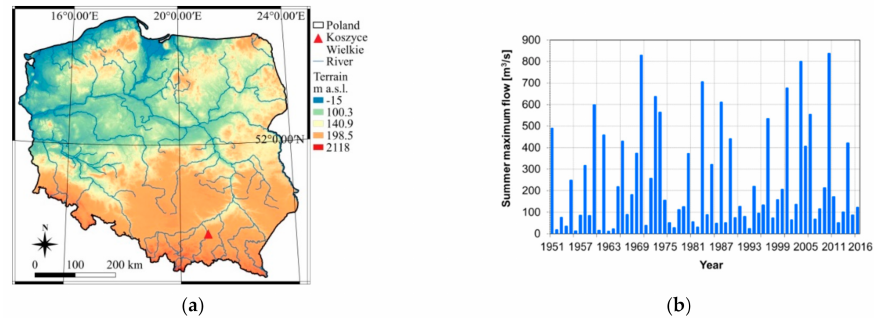
Figure 1. Data of the Koszyce Wielkie gauging station on the Biała Tarnowska river: ( a ) location in Poland; ( b ) observed summer maximum